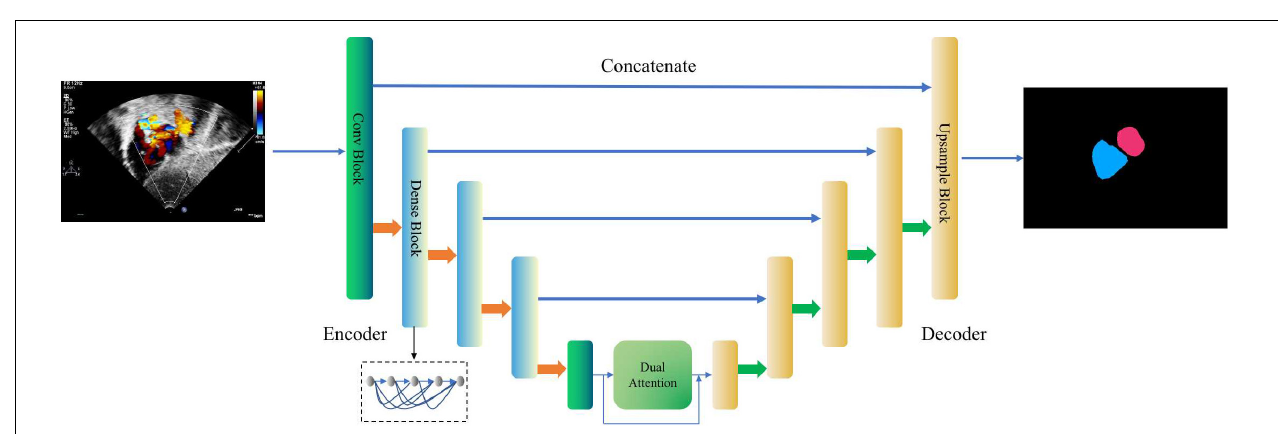
FIGURE 2 | Standard view identification through knowledge distillation. The pre-training teacher–student based on KL (Kullback–Leibler) loss realizes knowledge transfer through joint training. Then the student is fine-tuned on training data based on CE (cross entropy) loss to complete the training process of knowledge distillation.